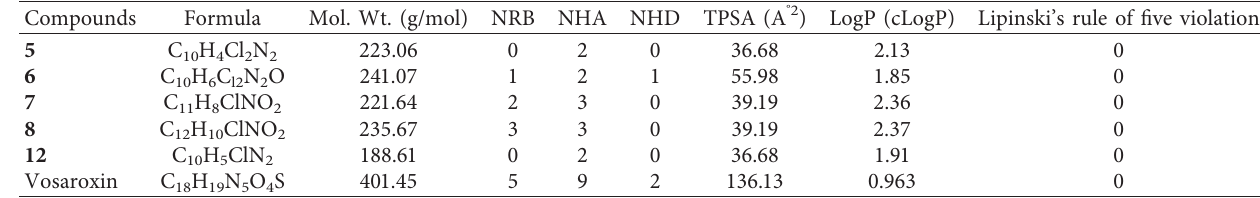
Table 5: Drug-likeness predictions of compounds 5 – 8 and 12 computed by